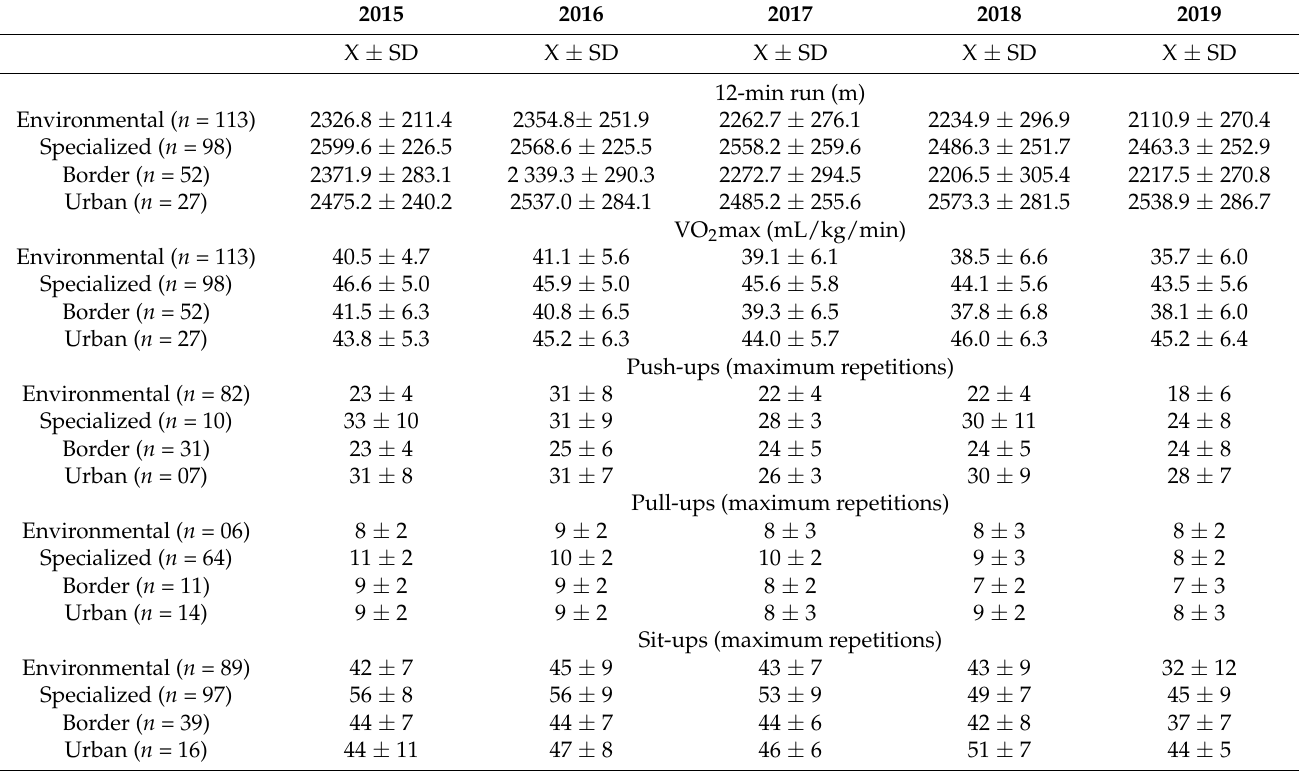
Table 1. Descriptive values of the performance of military police officers according to the